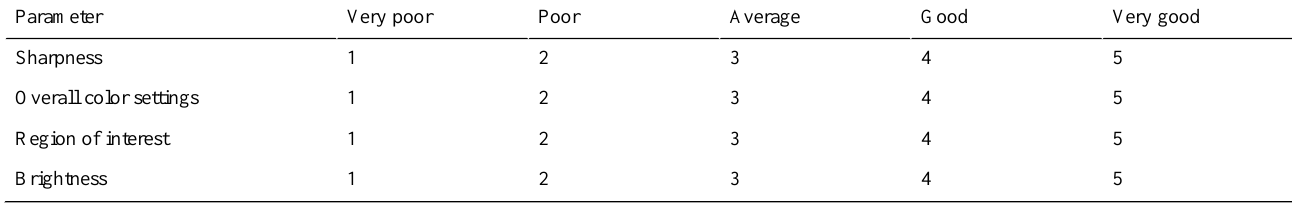
Table 1. Scoring system for image